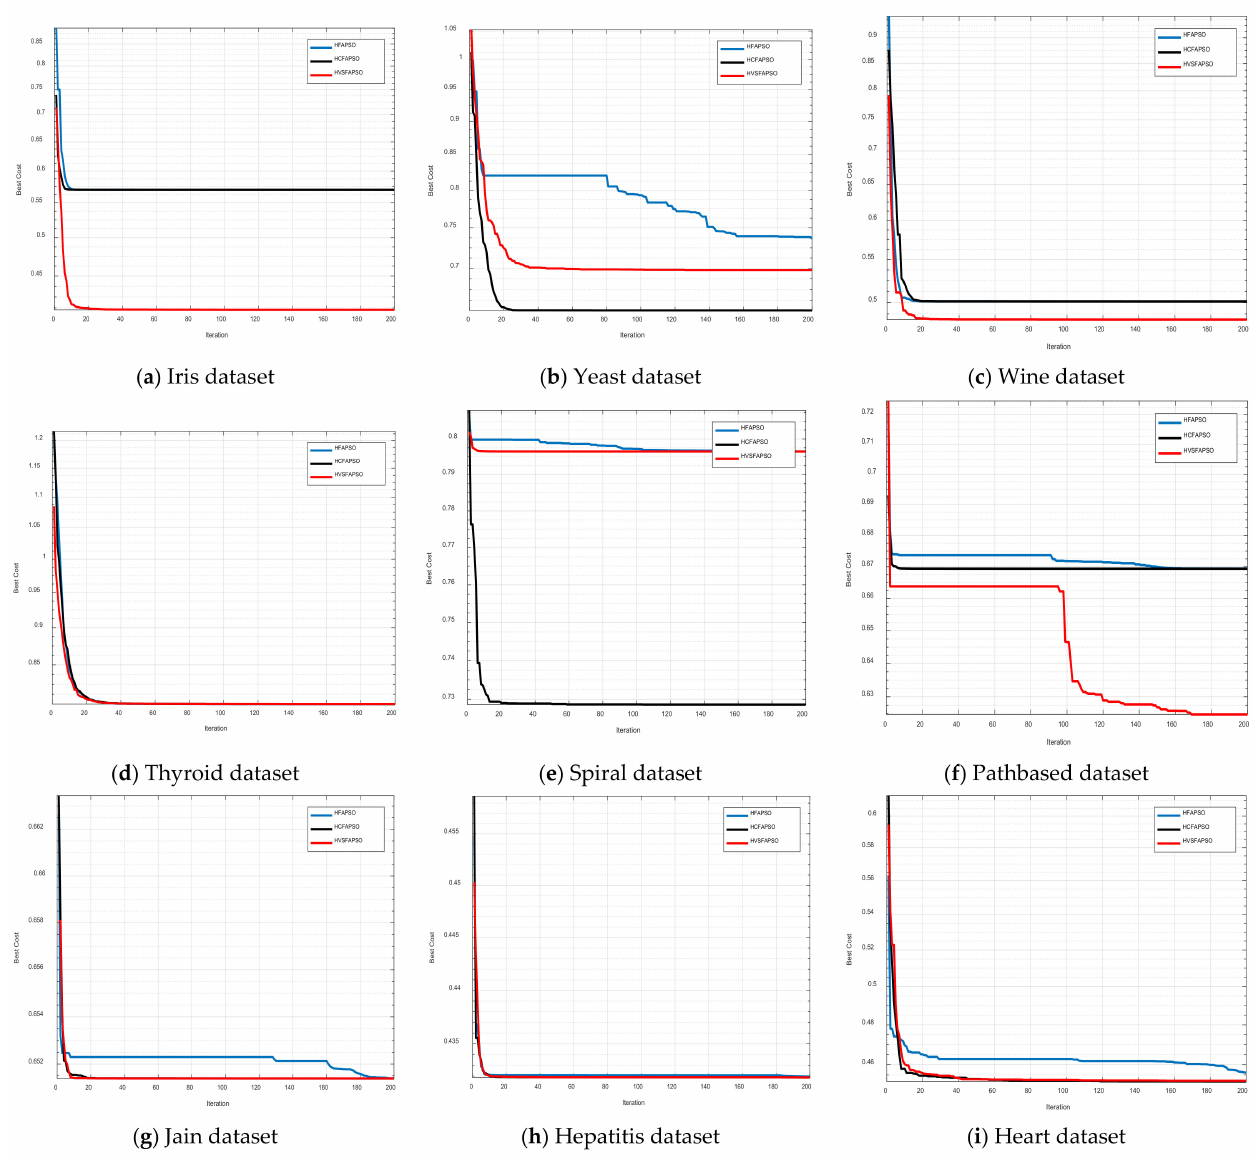
Figure 8. Convergence curves for all used datasets on CS-index.